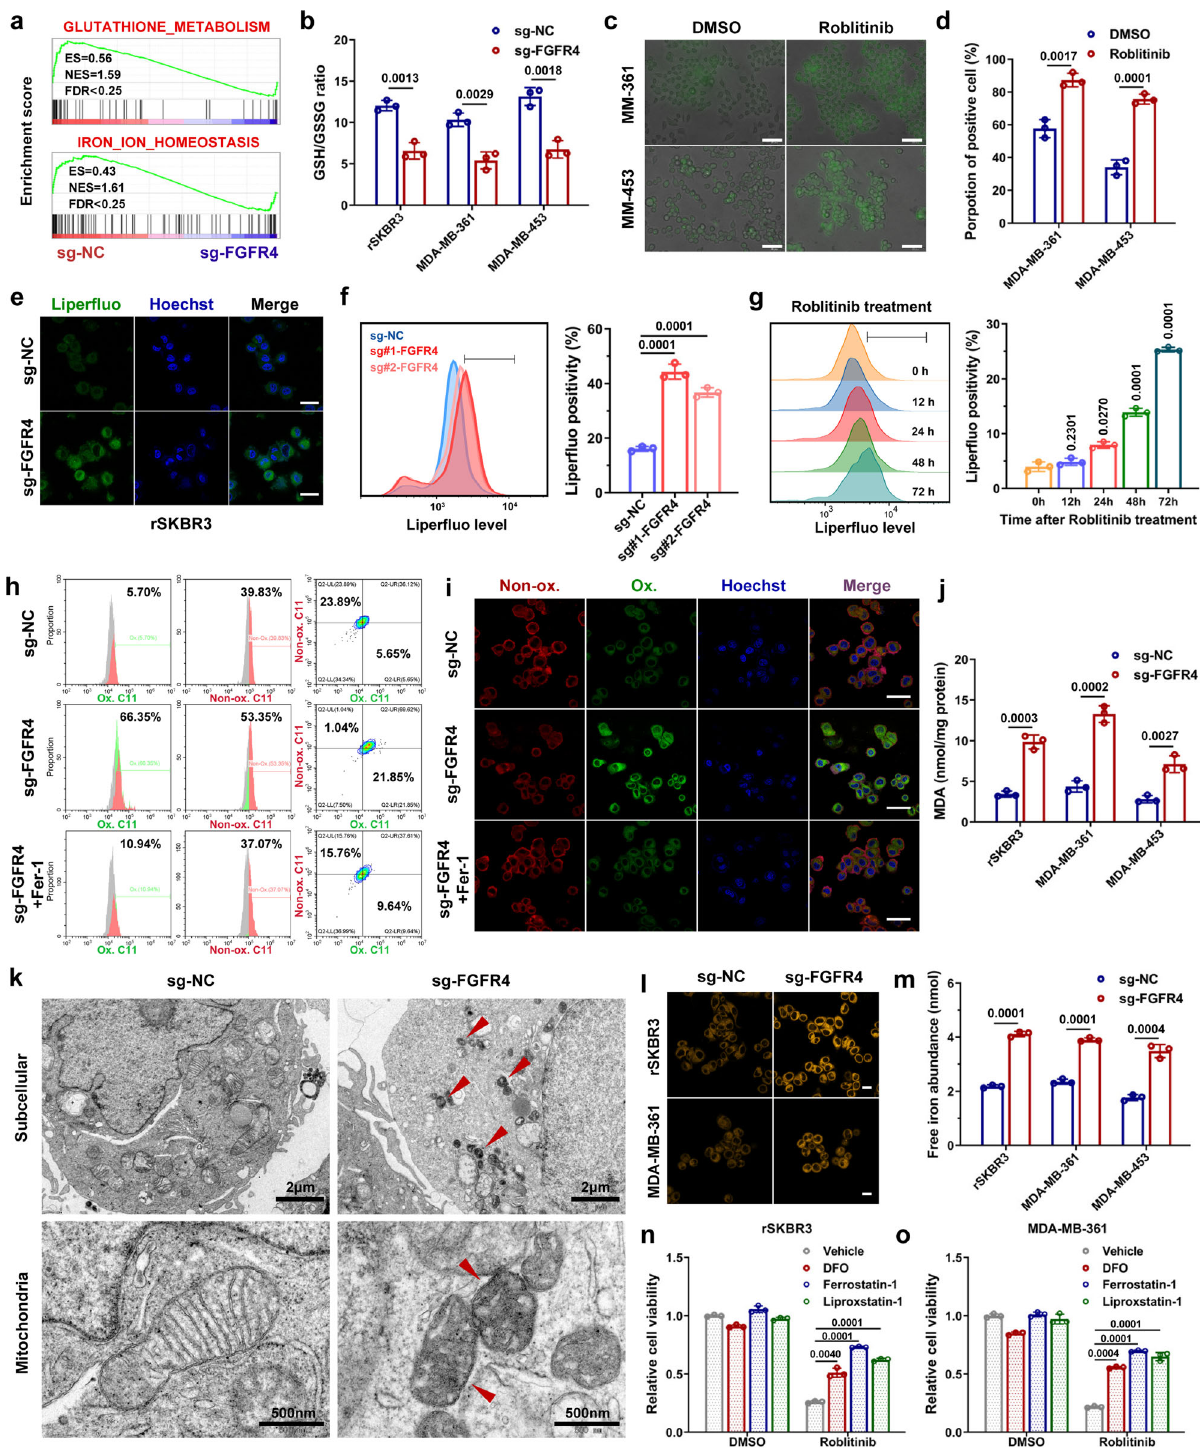
cellular survival following pharmacological HER2 signal blockade. As a member of the TKI family, FGFR4 is a druggable target with a fi rst-in-class highly selective and potent inhibitor, roblitinib. Validated in both intrinsic and acquired trastuzumab-resistant HER2-positive cell lines and cell-derived xenograft models, inhibition of FGFR4 dramatically increased cell and tumor sus- ceptibility to anti-HER2 therapy. Furthermore, PDX and PDO models were established to better examine the ef fi cacy of robli- tinib in anti-HER2 resistant breast cancer. The PDX model